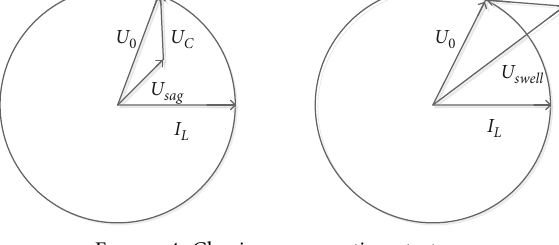
Figure 4: Classic compensation strategy.